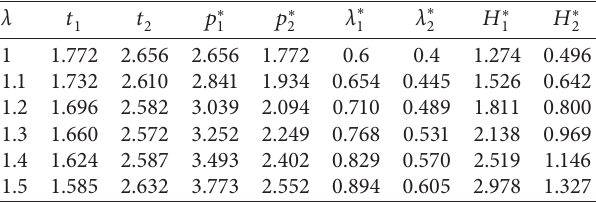
Table 1: Optimal parameters of services in